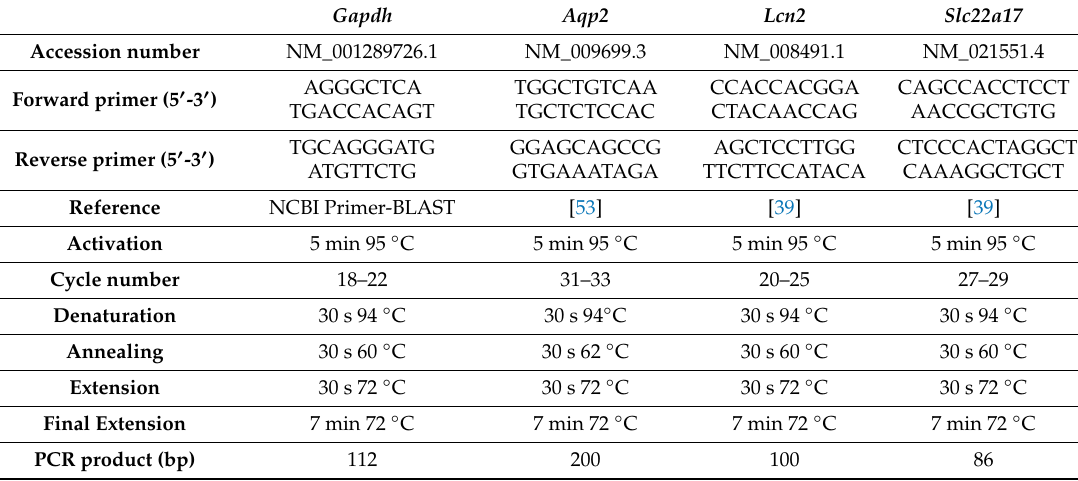
Table 2. Protocols for reverse transcription